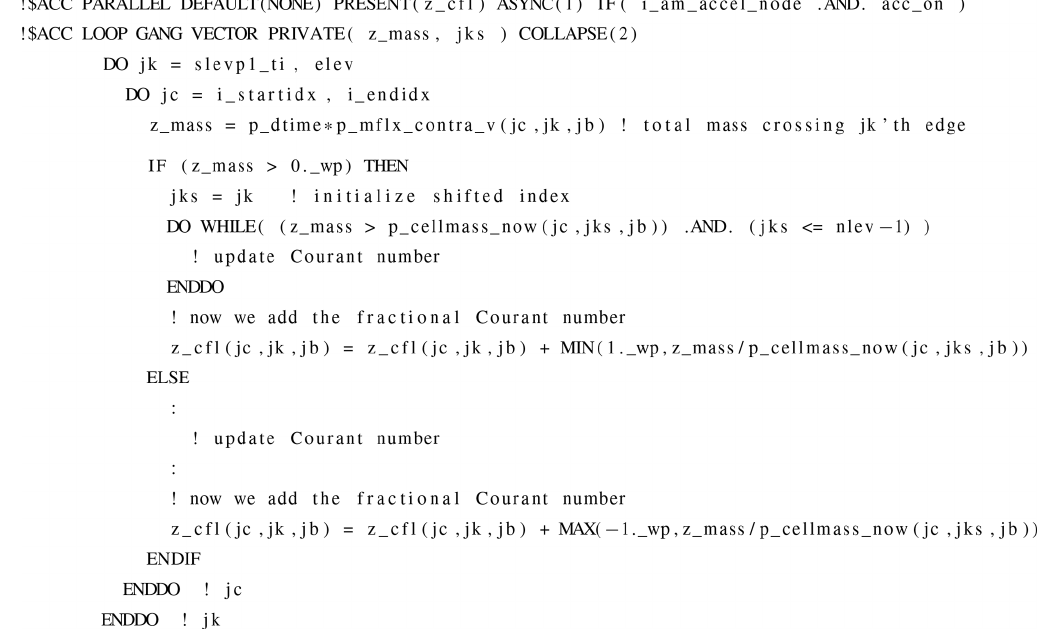
Listing 4. Index list-free implementation adapted for accelerator